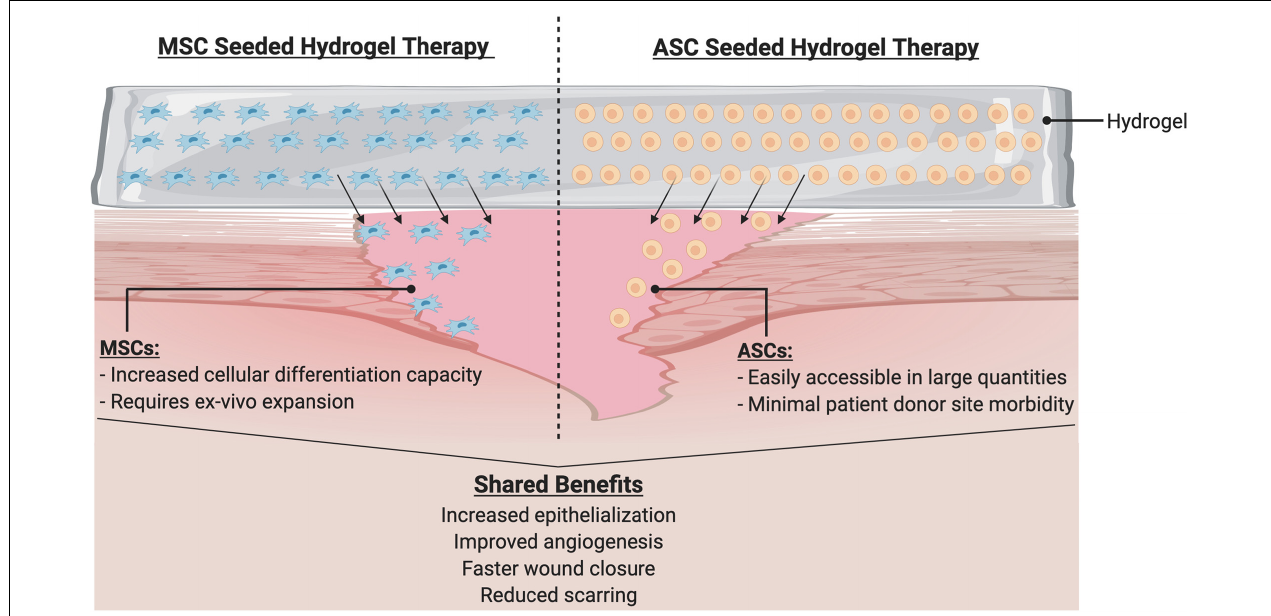
FIGURE 6 | Hydrogel with cellular therapy promotes wound healing. Hydrogel delivery system serves as a physiologic milieu to encapsulate cells to ensure efficient delivery to wound site. Cells such as MSCs or ASCs may be seeded into the hydrogels. Upon application to the wound, cells migrate into the wound to initiate a cascade of beneficial